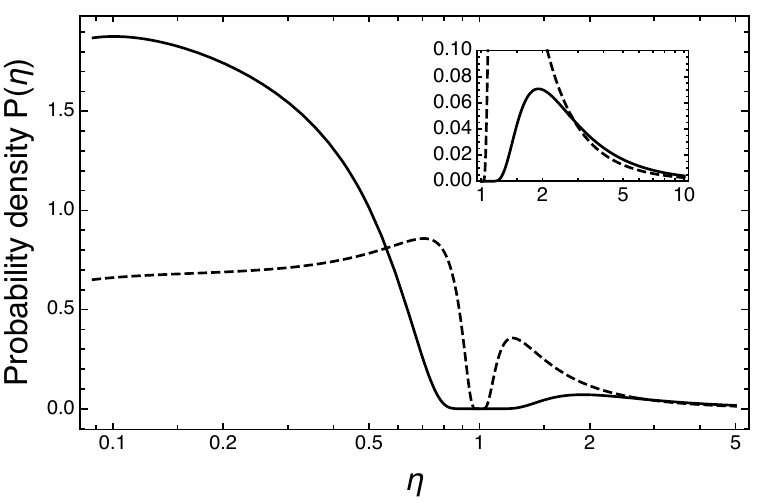
Figure 3 . Posterior probability density for (cid:17) given current cosmological and oscillation data. Note the logarithmic scale on the horizontal axis. The solid curve uses the Planck 2018+BAO as the cosmological dataset, while the dashed curve is for Planck 2018 only. The inset shows a blow-up of the region (cid:17) > 1. Note also the di(cid:11)erent scale in the vertical axes between the main panel and the inset. The region (cid:17) < 1 ( (cid:17) > 1) corresponds to normal (inverted) ordering. Quasi-degenerate neutrino masses are realized for (cid:17) ’